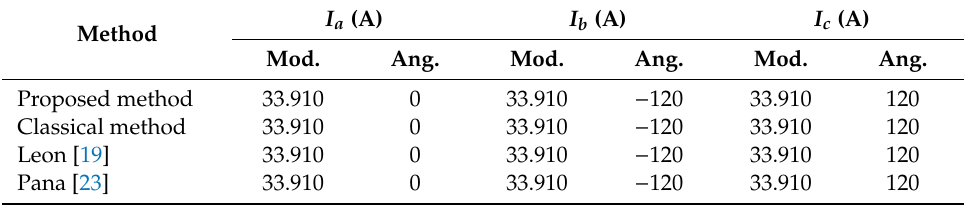
Table 9. Comparison of the proposed method with other methods with unbalanced